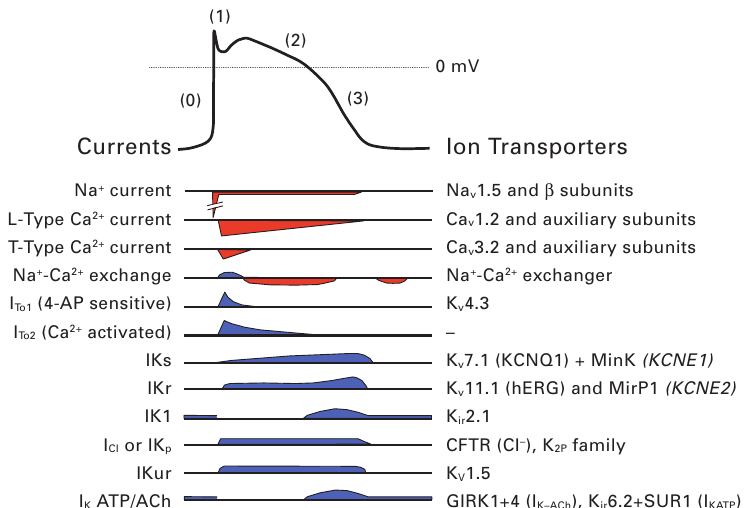
Schematic representation of the ionic currents and ion transporters responsible for the different phases of the cardiac action potential (AP). Red (depolarising) and blue (repolarising) shapes are indicative for relative current amplitude, duration and direc- tion. The shape of the current is aligned with its approximated time of action during the AP. The phase 0 (upstroke depolarisation) is caused by the very rapid activation of voltage-gated sodium channels Na v 1.5. These channels will afterwards inactivate rapidly. The first repolarisation phase 1 (notch) is due to the transient outward K + current for which two components are recognised, I to1 and I to2 . The plateau phase 2 is mainly maintained by inward Ca 2+ current flowing through Ca v 1.2 voltage-gated channels that inactivate slowly. Repolarisation (phase 3) is obtained through the con- certed action of three types of outward currents called IKs (slow), IKr (rapid) and fi- nally IK1. The main pore forming subunit (alpha subunits) of IKs is called K v LQT1 or